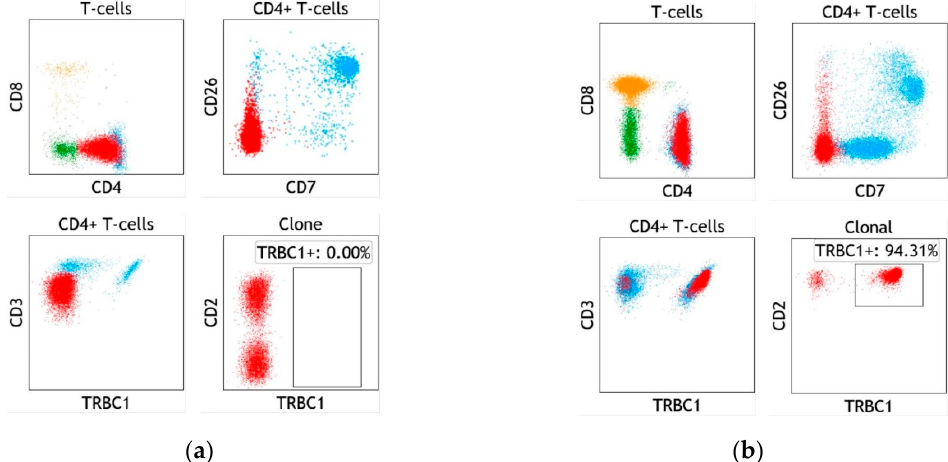
Figure 5. Examples of peripheral blood involvement by cutaneous T-cell lymphoma, showing TRBC1-restricted CD4-positive T cells consistent with Sezary cells. ( a ) A blood sample from a patient with advanced mycosis fungoides shows typical CD4-positive Sezary cells (red) with aberrant diminished expression of CD3 and CD4, and negative for CD7 and CD26, accounting for 991 cells/ μ L. Two clusters are identified based on CD2 expression, both of which likely correspond to the same TRBC1-negative T-cell clone. ( b ) A case of Sezary cells with no detectable tumor-specific immunophenotypic abnormalities in a patient with mycosis fungoides. The conventional immunophenotypic analysis shows only a relative increase in CD4-positive T cells lacking CD7 and/or CD26, a feature also observed in some reactive settings. Analysis of TRBC1 expression on CD4-positive T-cells shows T-cell clonality in the CD7/CD26 double-negative subset (red), but not in the expanded CD7-dim/CD26-negative population, consistent with a Sezary cell count of 585 cells/ μ L. In addition, shown are background polytypic CD4-positive (cyan) and CD8-positive (orange) T cells and other non-gated events (green). T cells were gated based on CD3 expression, and absolute Sezary cell counts were estimated by correlation with the absolute lymphocyte count obtained separately on a hematology analyzer.